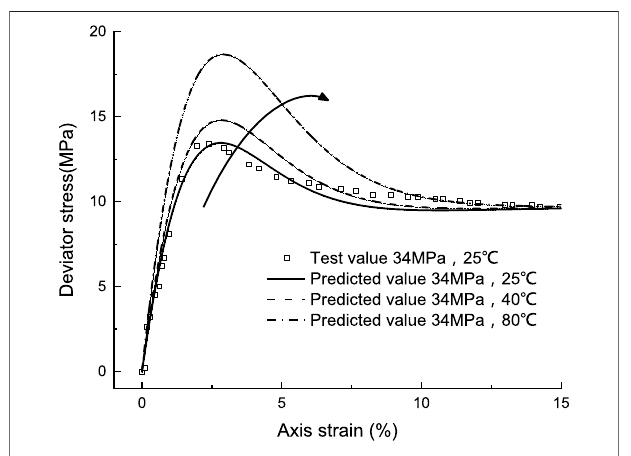
FIGURE 6 | The change of pore pressure in undrained shear test of dense sandy soil under different